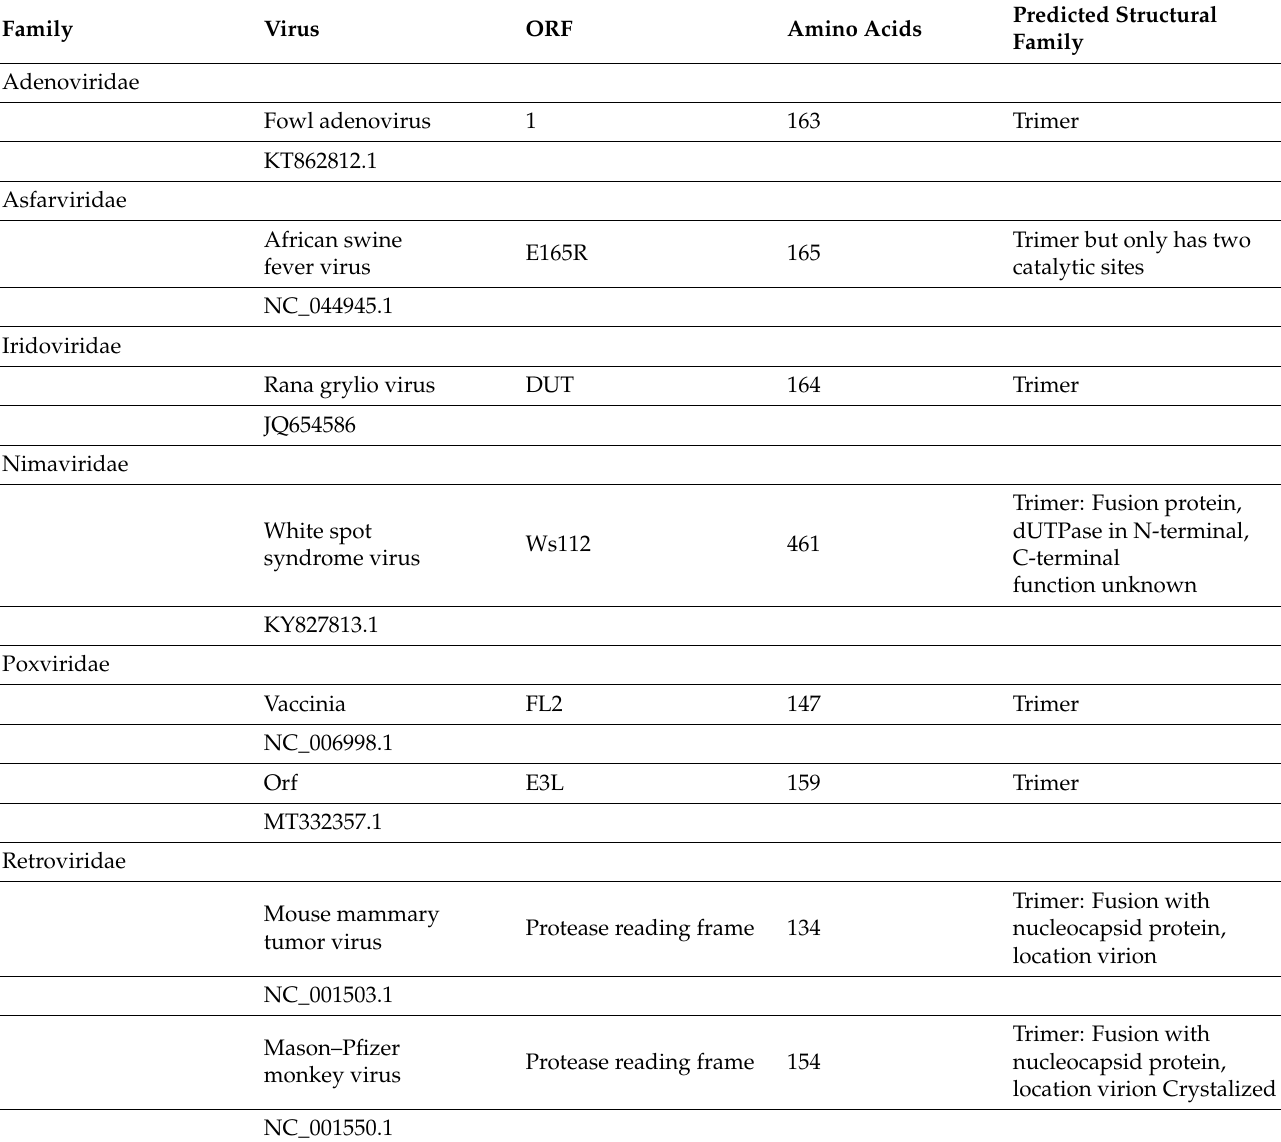
Table 2. Validated